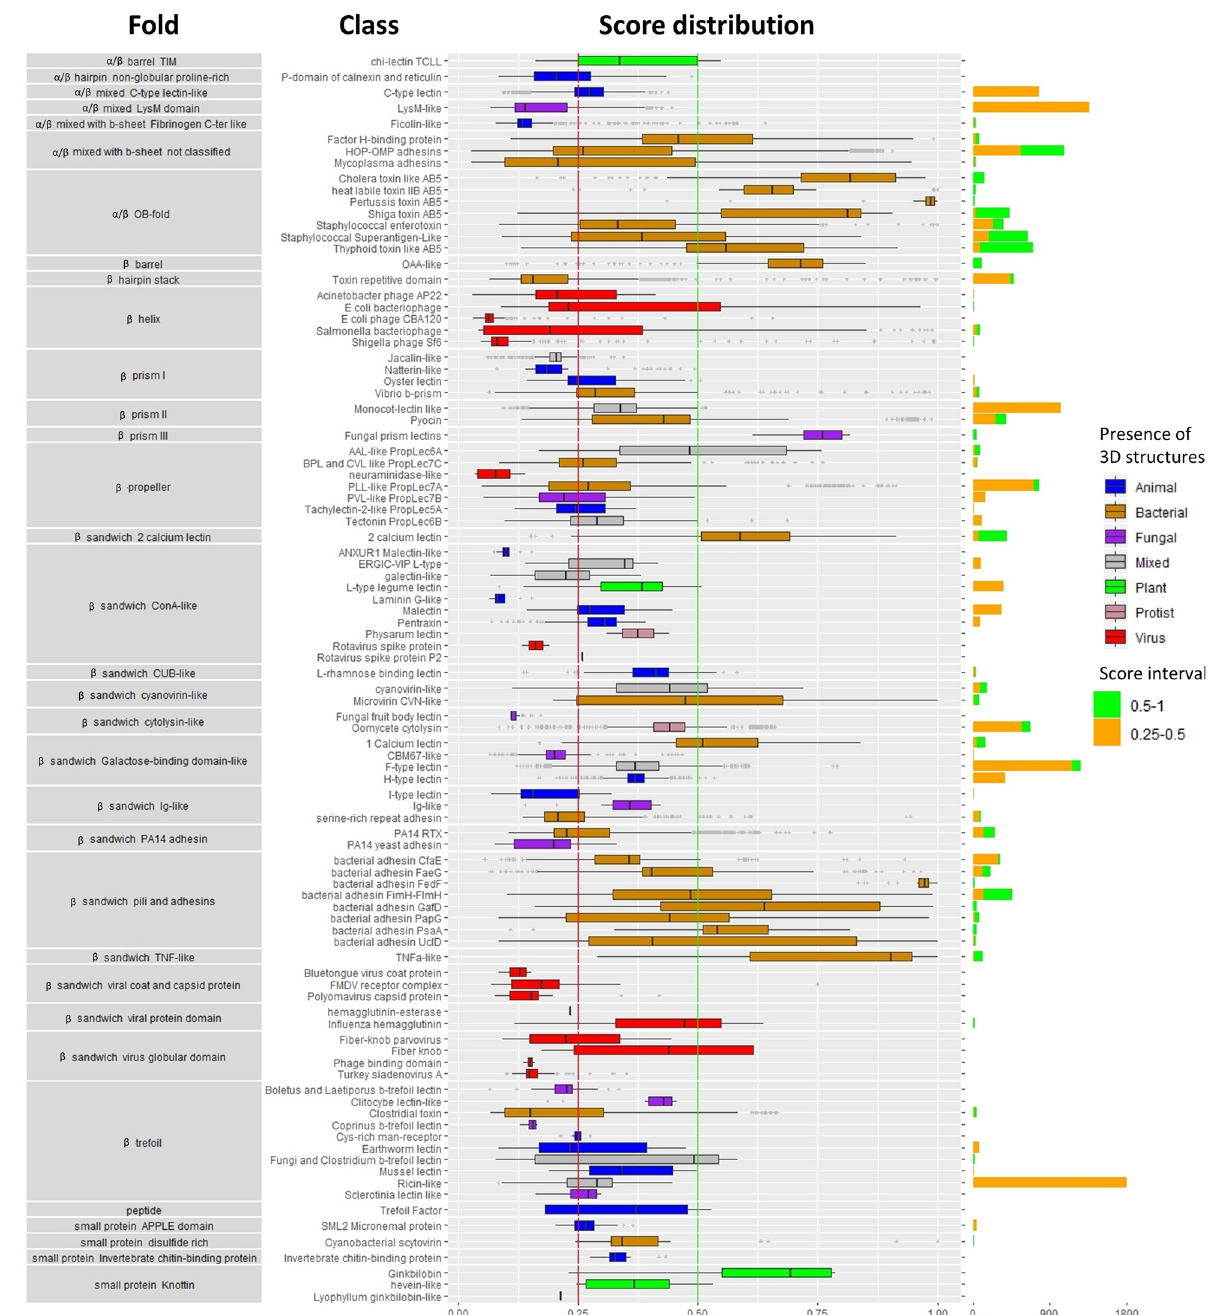
Fig. 2 Distribution of structural folds in predicted bacterial lectins based on UniLectin3D lectin classes. The distribution of the predicted lectin classes is presented as horizontal boxes and whisker plots coloured on the basis of lectin class origin. The whisker plot represents the minimum, maximum, median, fi rst quartile and third quartile in each class. Values approaching 1 are indicative of high sequence similarity to the reference motif. The predicted lectins in [0.25 – 0.5] and [0.5 – 1] score intervals are presented as bar graphs. The total number of predicted lectins in each class is listed in Supplementary Table